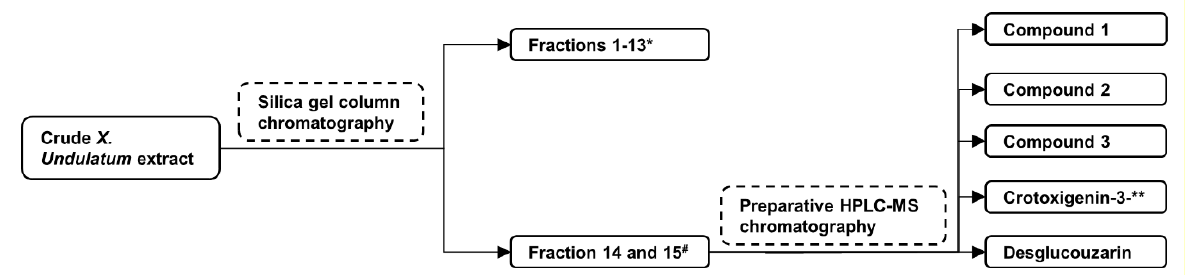
Figure 1. Illustration of the bioassay guided isolation of compounds 1 , 2, and 3 from X. undulatum crude extract. These compounds where isolated from the same fractions (14 and 15) from which the cardenolides ** crotoxigenin-3- O - β -digitalopyranosyl-(1-4)- O - β -digitoxopyanoside and desglucouzarin where isolated from [6]. * Fractions 1-13 previously demonstrated poor activity (<20% inhibition of A β 42 formation) while # fractions 14 and 15 both showed good activity (>70% inhibition of A β 42 formation) at 50 μ g/mL.